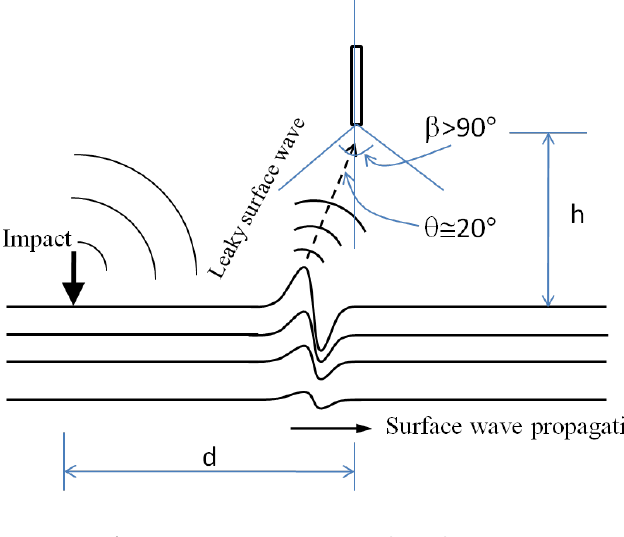
Figure 1. Propagation of surface wave.